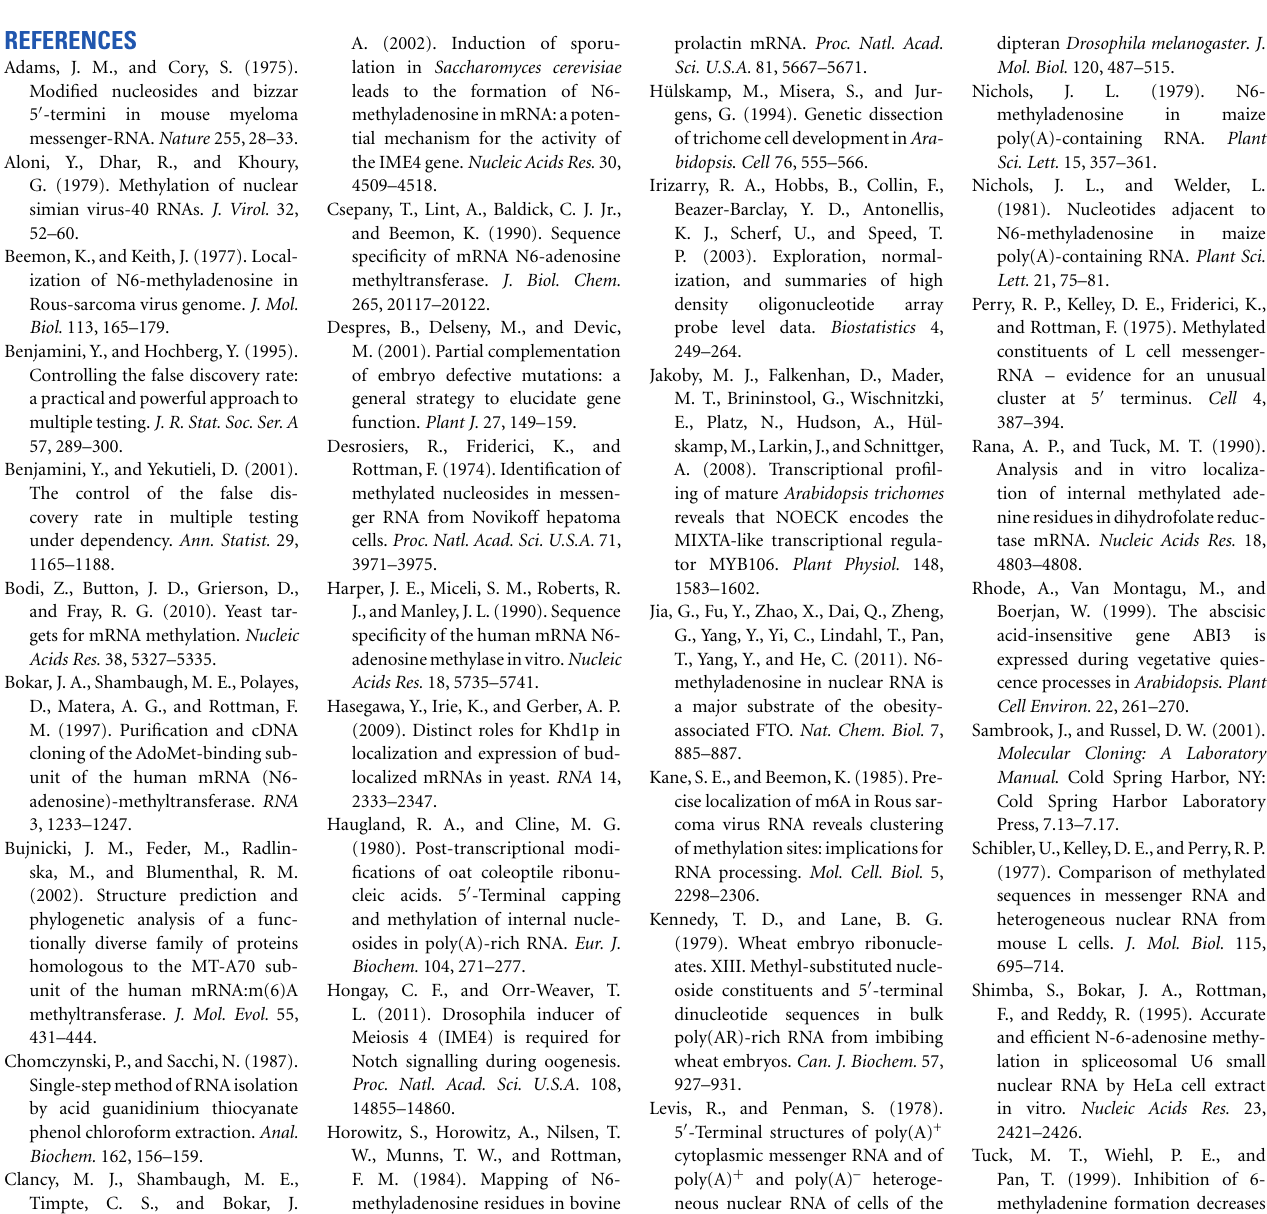
Table S1 | Differentially expressed genes.